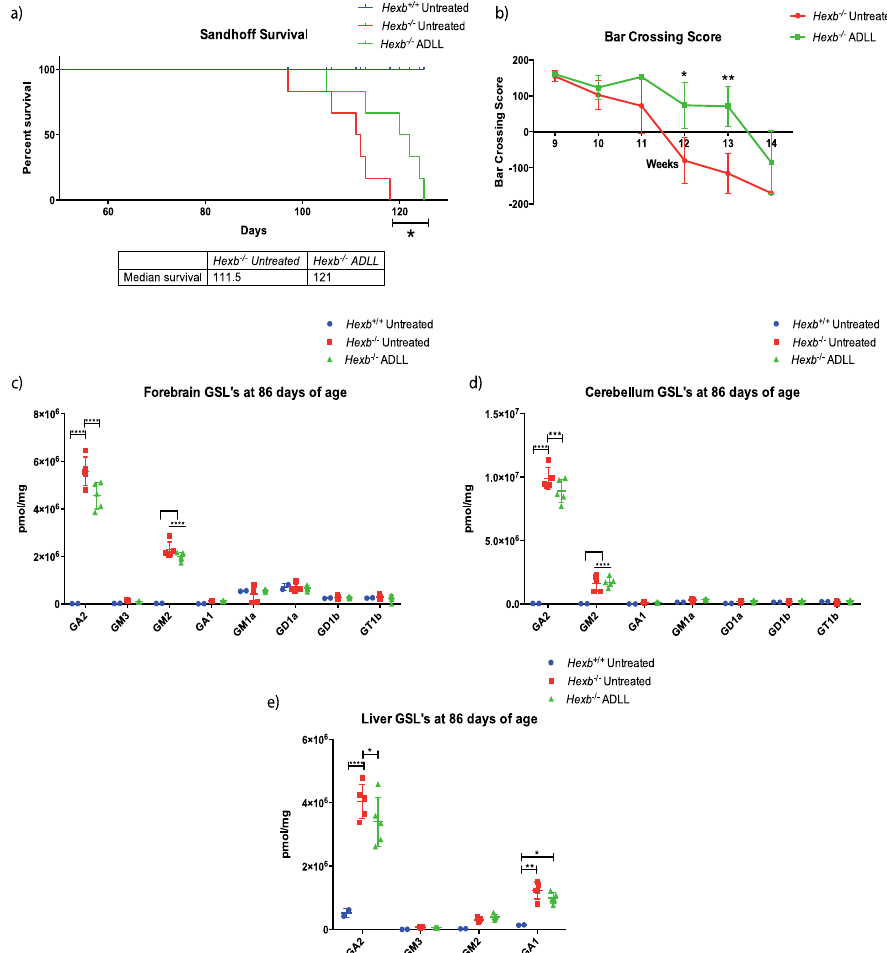
Figure 1. Effects of acetyl-DL-leucine on behavioural and biochemical parameters in Sandhoff disease ( Hexb -/- ) mice. The groups comprised Wild-type untreated ( Hexb +/+ ), Sandhoff untreated ( Hexb -/- UT), Sandhoff ADLL treated ( Hexb -/- ADLL). In total, 2–5 animals for Hexb +/+ , 5–6 animals for Hexb -/- UT and Hexb -/- ADLL. ( a ) Changes in life expectancy (%); n = 6 for Hexb -/-- untreated and ADLL treated, n = 5 for Hexb +/+ , mean ± SD, * p = 0.0247 (log-rank test). ( b ) Bar crossing score, n = 6, mean ± SD, * p = 0.0343, ** p = 0.0058 (two-way ANOVA). ( c ) GSL measurements of forebrain (brain) at 86 days of age. Mean ± SD, **** p < 0.0001, (two-way ANOVA). ( d ) GSL measurements of cerebellum at 86 days of age. Mean ± SD, *** p = 0.0002, **** p < 0.0001, (two-way ANOVA). ( e ) Liver GSLs at 86 days of age. Mean ± SD, * p < 0.0124, ** p = 0.0012, **** p < 0.0001, (two-way